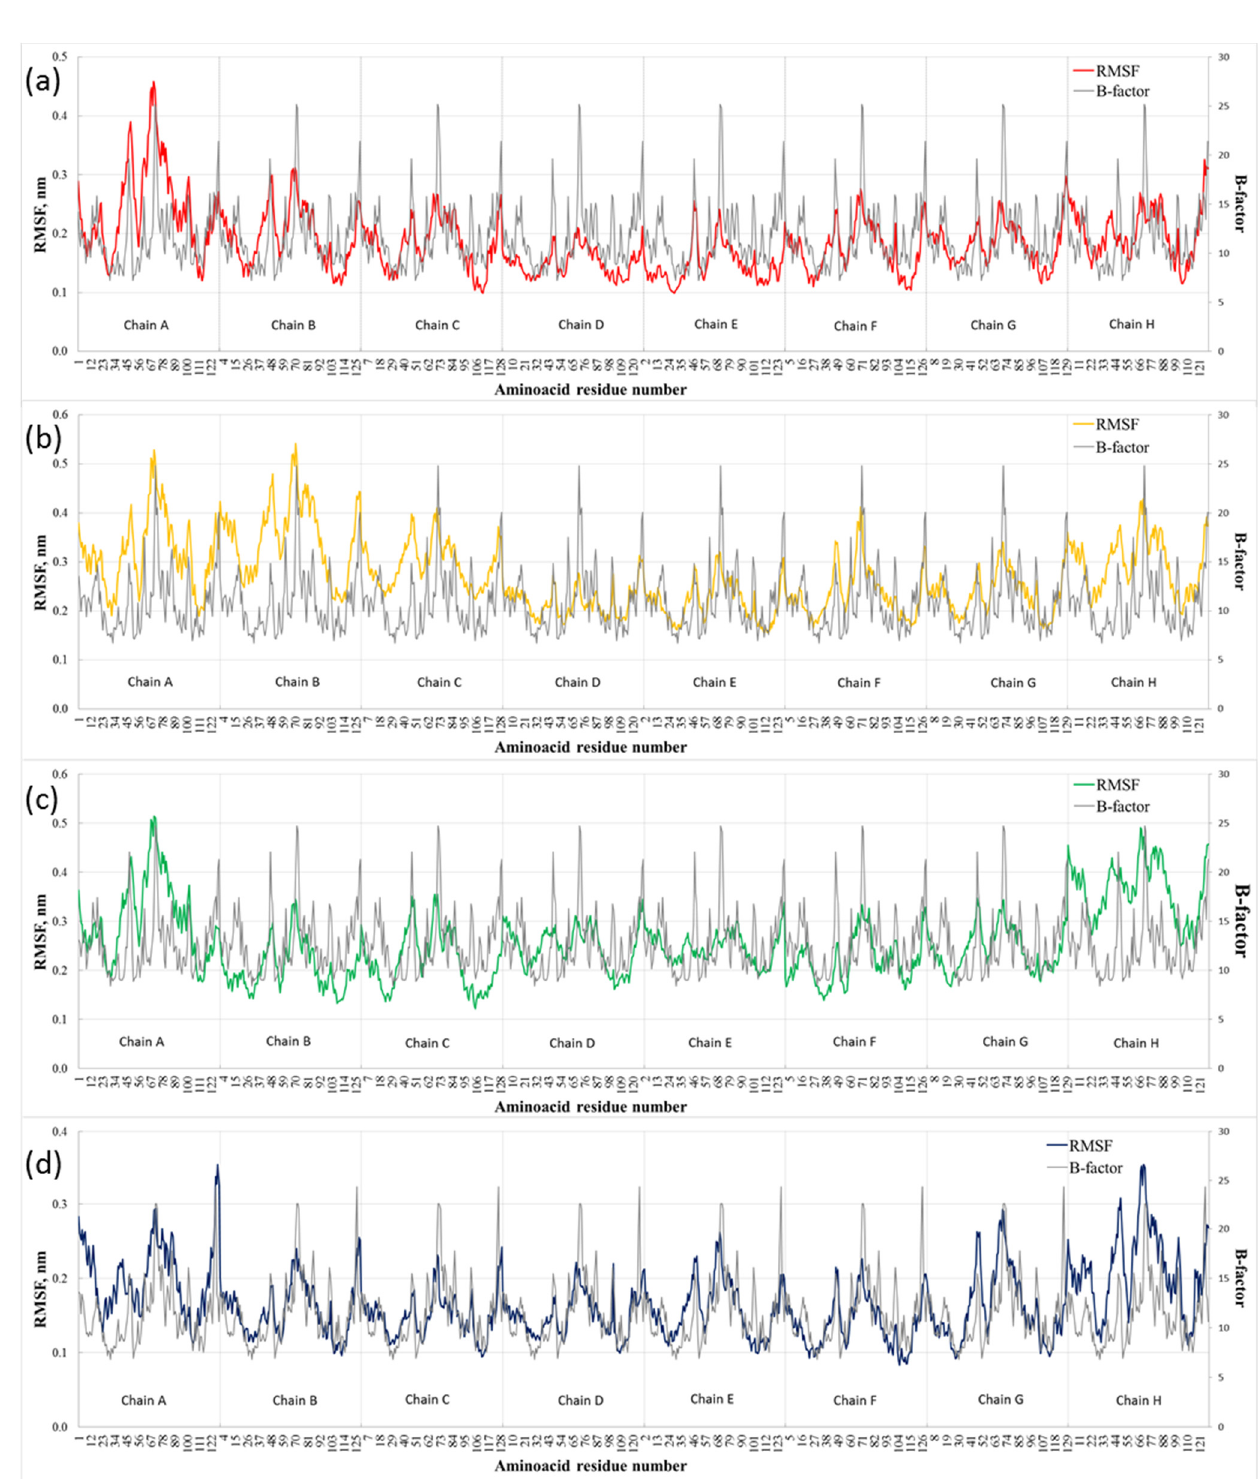
Figure 9. Comparison of the temperature B-factor with the RMSF of octamers with different precipitants: LiCl ( a ), NaCl ( b ), KCl ( c ) and CuCl 2 ( d ). Chains A–H are the polypeptide chains of octamers.